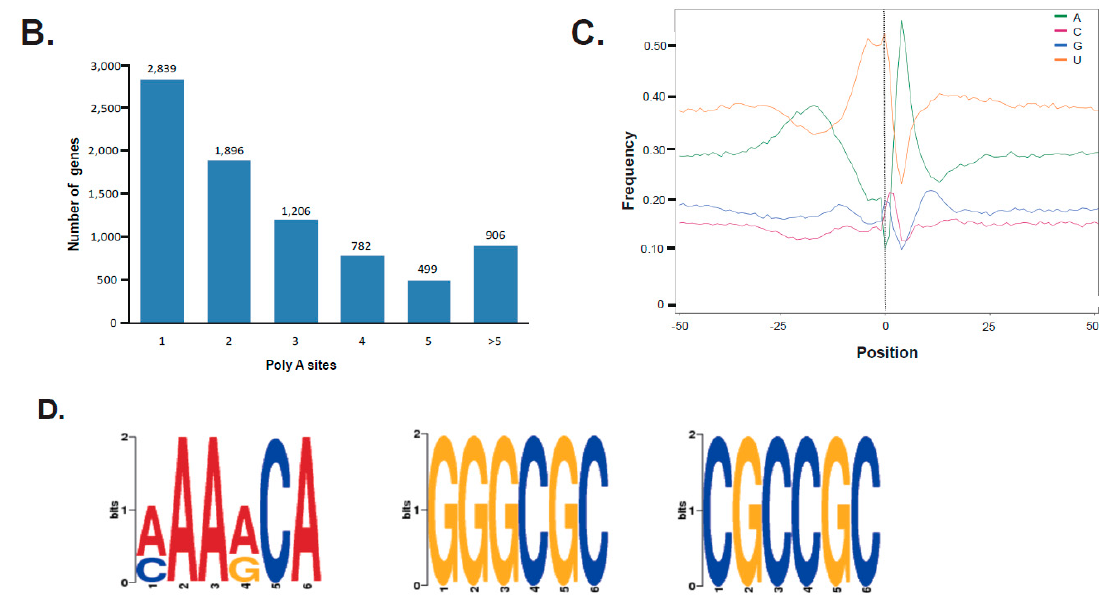
Figure 4. ( A ) A schematic graph and distribution of varied alternative splicing (AS) events found in the female strobili of G. luofuense ; ( B ) Distribution of the number of poly (A) sites (x-axis) associated with gene numbers (y-axis); ( C ) The nucleotide composition around poly (A) cleavage sites was presented with the relative frequency of a nucleotide (y-axis) and transcriptome composition cross all poly (A) cleavage sites (x-axis); ( D ) three over-represented motifs at 25 nts upstream of the poly (A) site for all G. luofuense full-length transcripts.